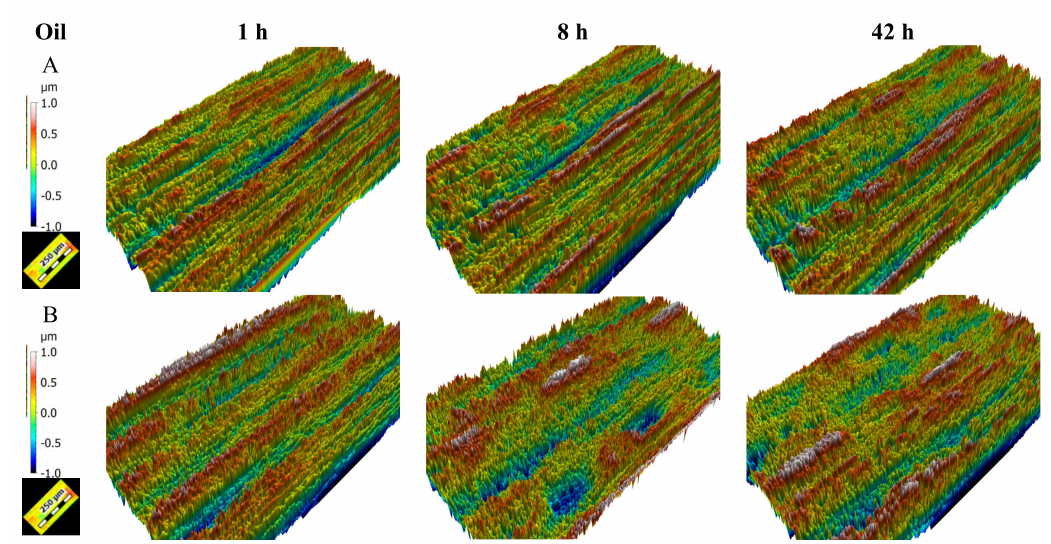
Figure 3. Evolution of surface topography after 1, 8 and 42 h of rolling-sliding test in lubricated conditions with respectively lubricant A and lubricant